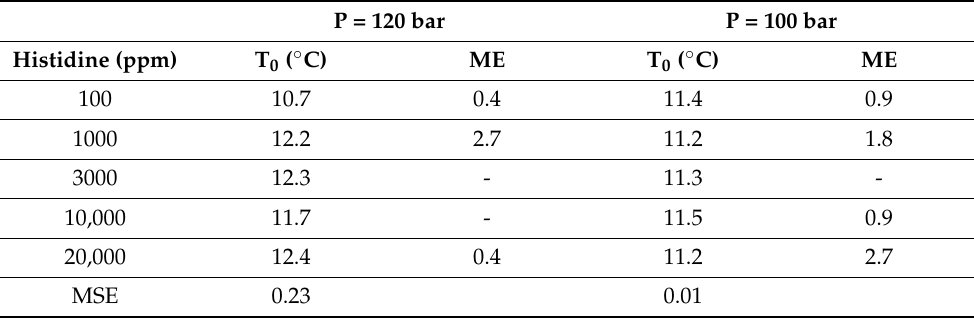
Table A2. Onset nucleation temperature T 0 ( ◦ C) (averaged) and Margin of error (ME) for L-histidine under different concentrations (100 ppm to 20,000